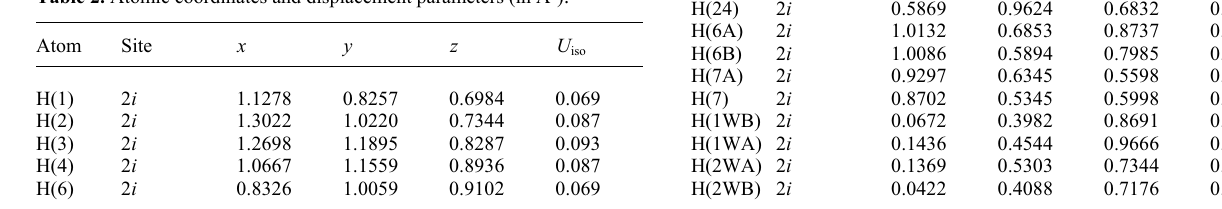
Table 2. Atomic coordinates and displacement parameters (in Å 2 ) .